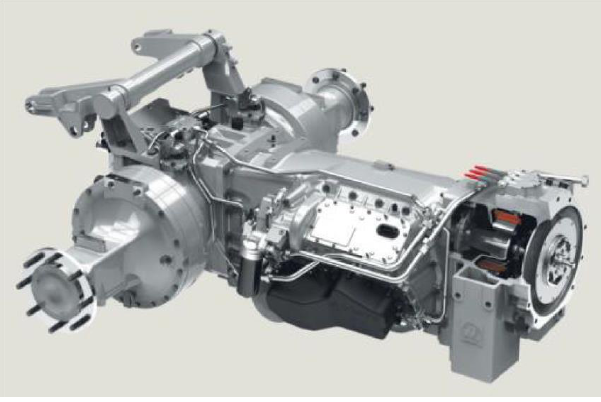
Fig. 18. ZF TERRA+ starter generator with transaxle [23]